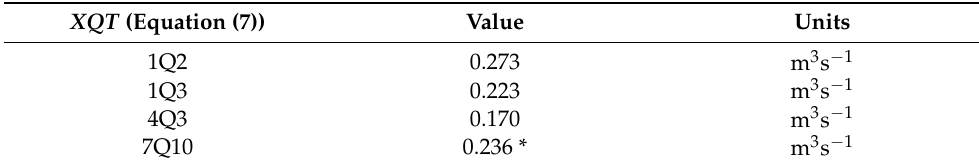
Table 8. Design conditions for steady flow at site S1:1.